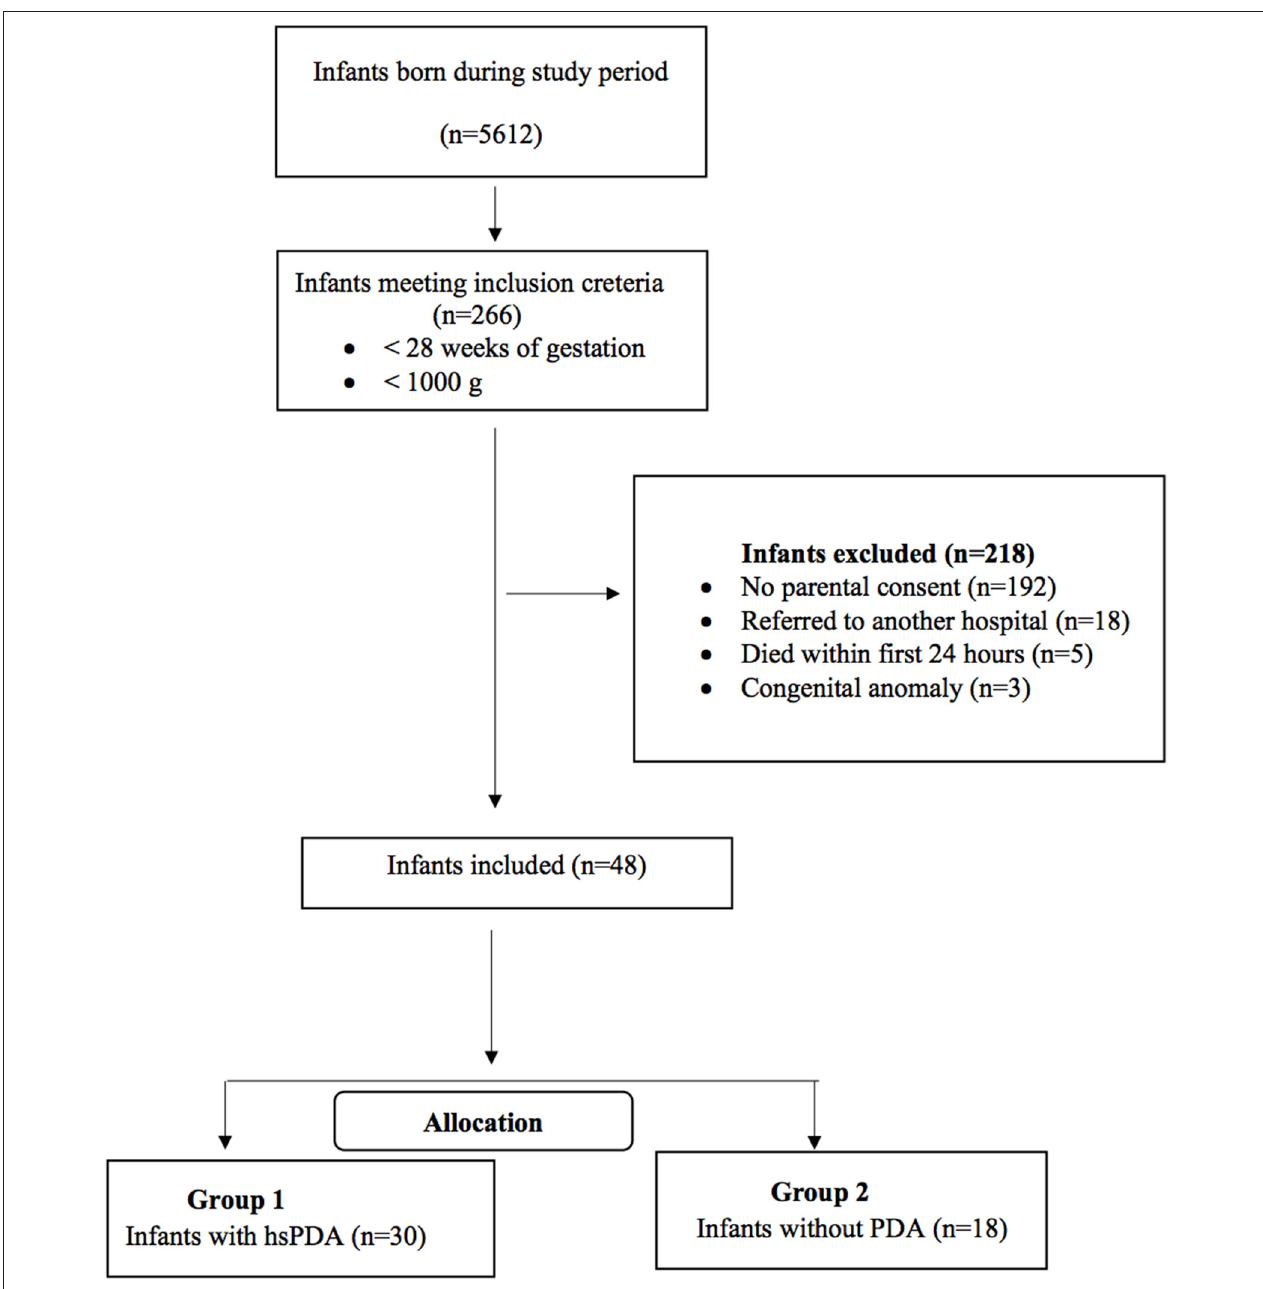
FIGURE 1 | Flow chart of the study population.